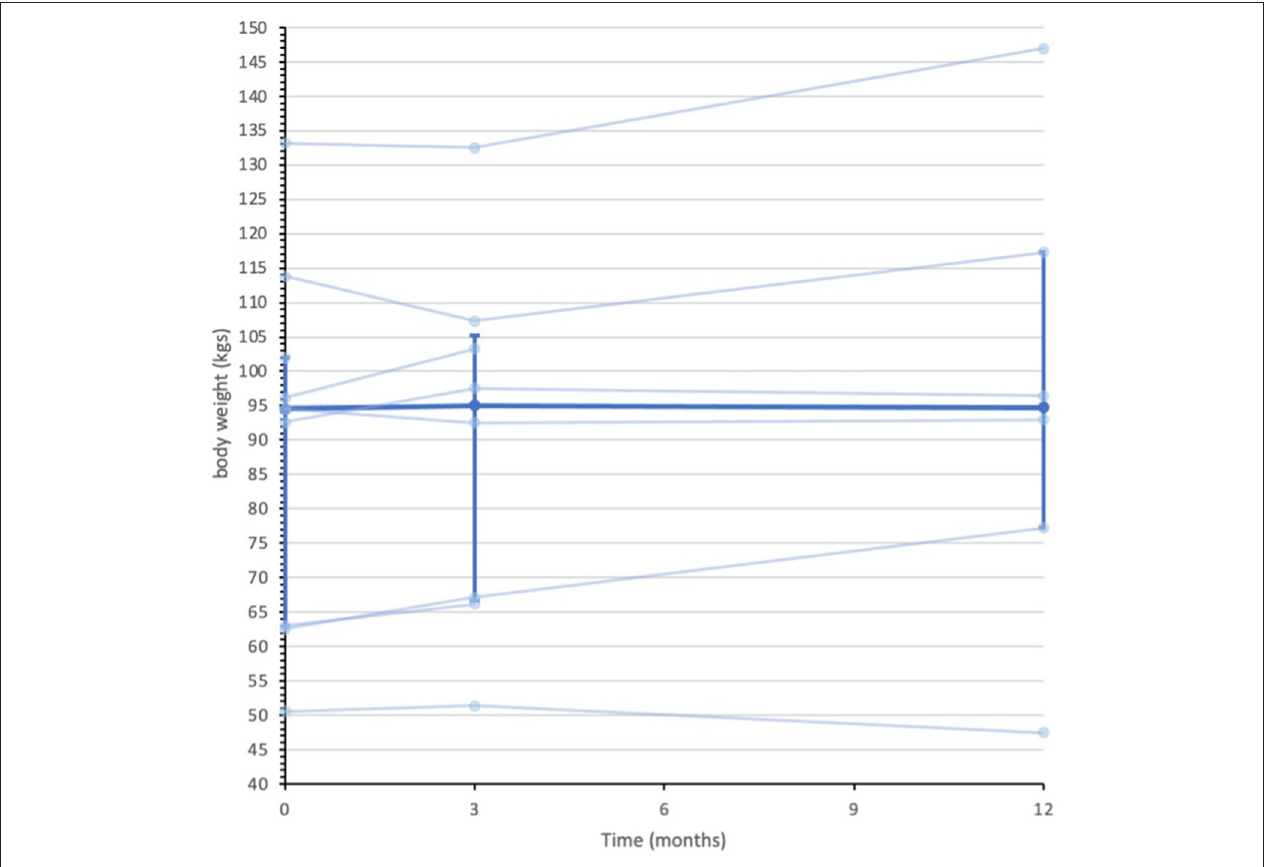
FIGURE 2 | Data series of individual and median body weight values for IG participants ( n = 9). Individual data series for participants in the intervention group depicted by the pale blue lines. Median depicted by darker blue line, with IQR error bars. Median was calculated from all recorded data at each assessment point. n = 9 at baseline, n = 8 at 3-months, and n = 6 at